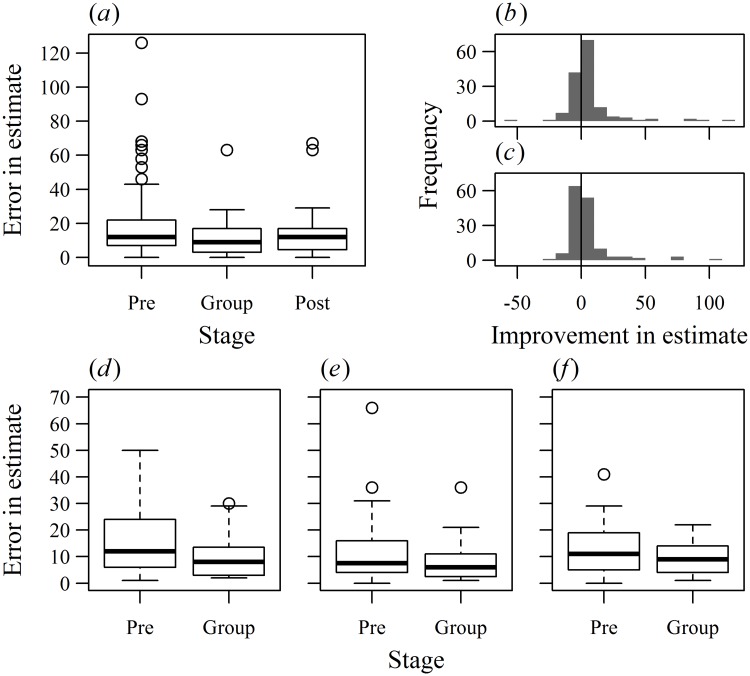
Collective intelligence in adolescents.In experiment 1 (a,b,c), the errors in the pre-discussion initial estimates are significantly greater than both the group consensus (neg. bin. GLMM: z = 6.74, p < 0.001) and post-discussion estimates (z = 5.27, p < 0.001). Group estimates tended to have less error on average than individual estimates given after discussion although this effect was not statistically significant (z = -1.77, p = 0.077). The frequency distributions of the error in the initial estimates minus the error in the group consensus estimates (b) or post-discussion individual estimates (c) per participant show that while most participants only gain a small improvement in reduced errors (b) or show little change in errors (c), a minority of individuals vastly reduce the error in their estimates after group discussion. In Experiment 2, the absolute error in the consensus group estimate was lower than the initial (pre) estimates in all three treatments (proportion of black sweets: d: 48/200, e: 94/190, f: 121/160). The box plots show the median (thick black lines), interquartile range (enclosed by the boxes), 1.5 × the interquartile range beyond the boxes (whiskers) and outliers beyond the whiskers (open circles).